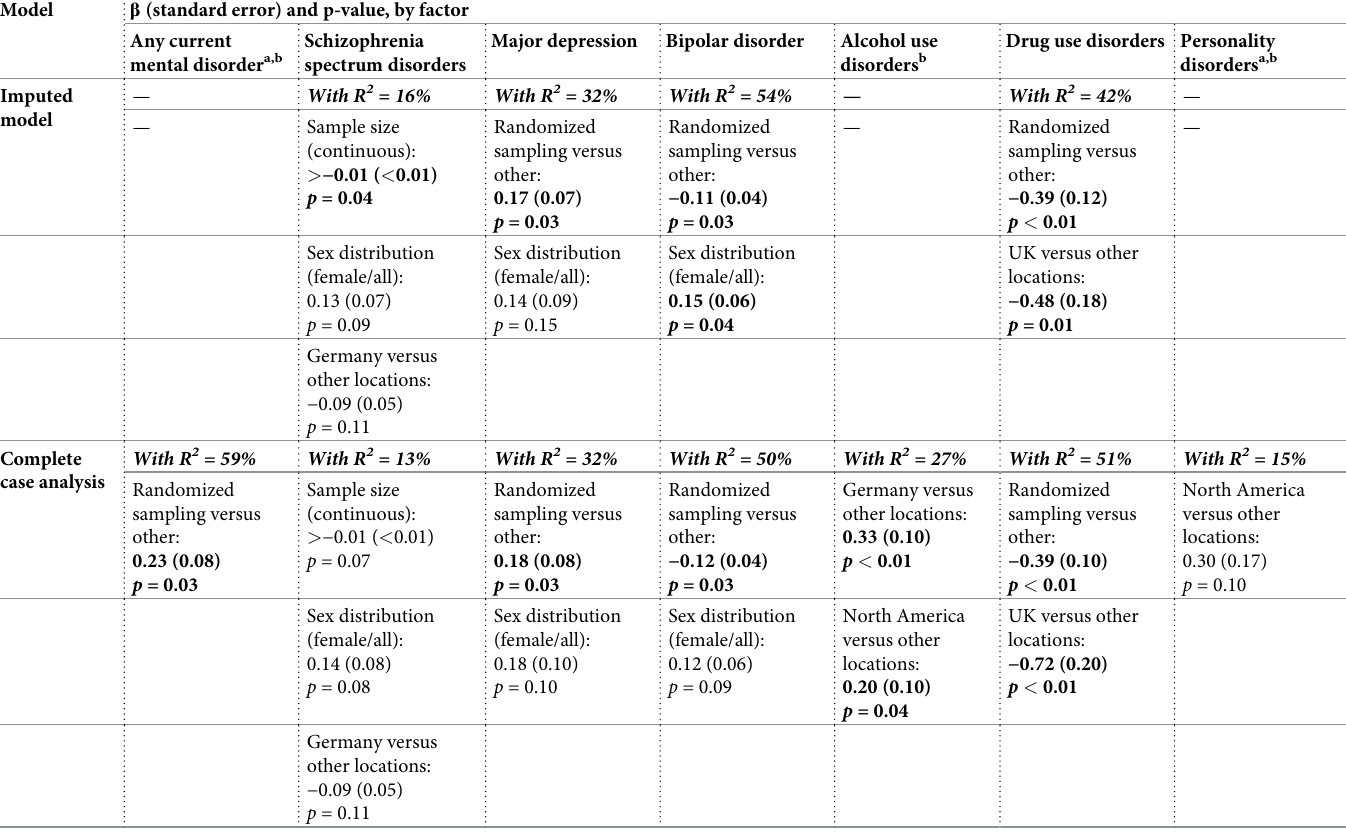
Table 1. Study-level factors associated with between-study heterogeneity in multivariable meta-regression AU : PleasecheckthattheeditstothecolumnheadsforTable 1 arecorrect : .